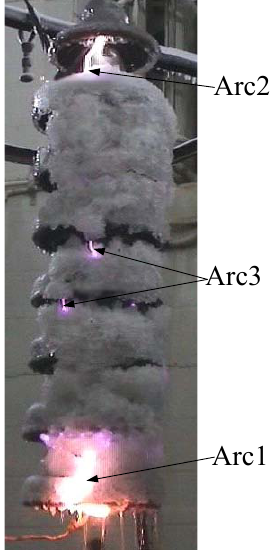
Figure 1. Multi-arc on ice-covered insulators during the DC flashover process.